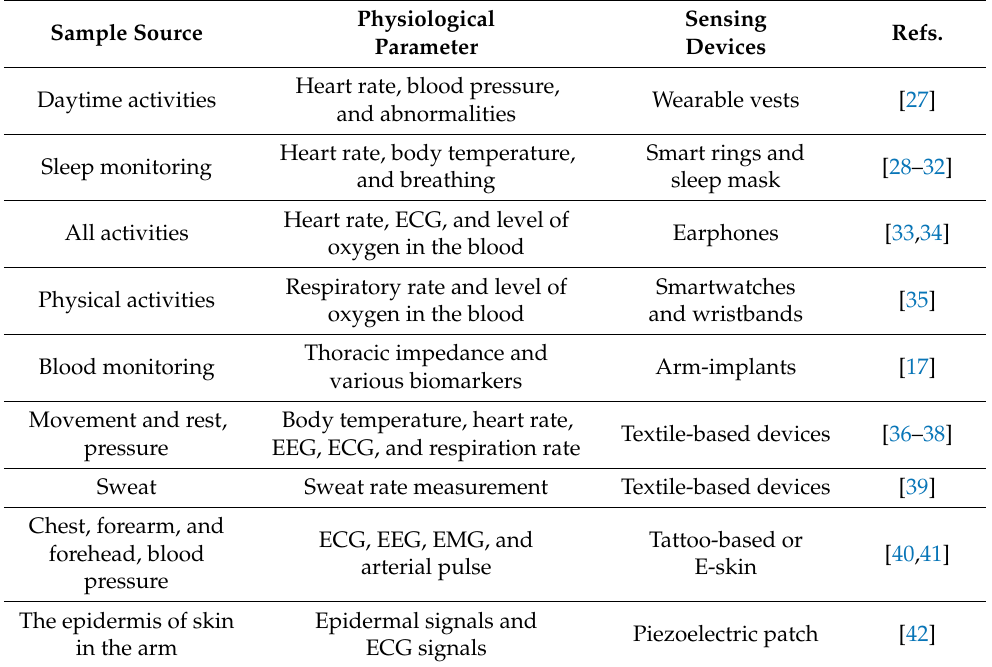
Table 2. Medical wearable devices currently used for health